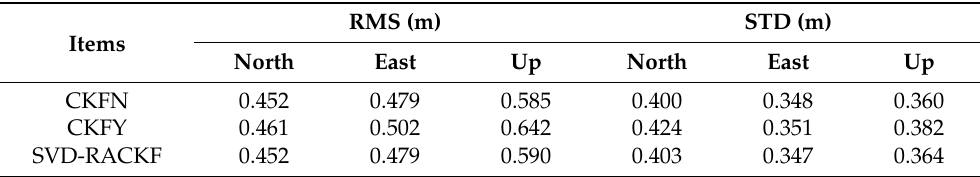
Figure 12. Position error of dual ‐ system (GPS + BDS) dual ‐ antenna GNSS/MIMU tightly coupled integration using different filtering schemes. Table 4. RMS and STD of the position error of dual ‐ system (GPS + BDS) dual ‐ antenna GNSS/MIMU tightly coupled integration using different filtering schemes.